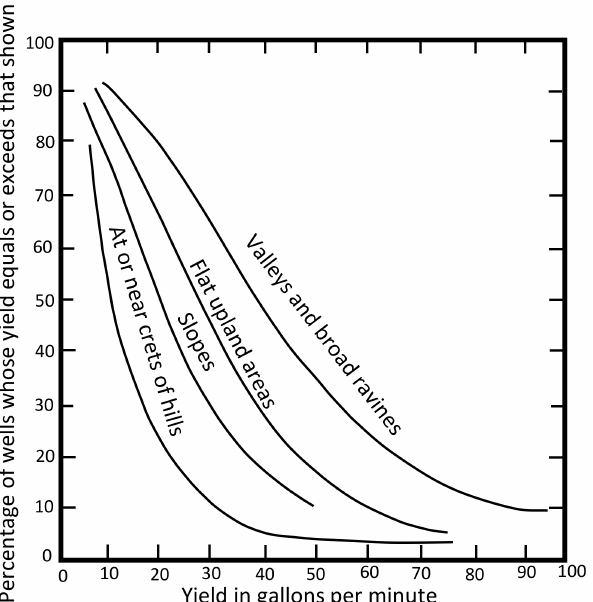
Figure 4. Relation between landform and potential well yield. Source: Freeze and Cherry (1979) [3] and LeGrand (1954)